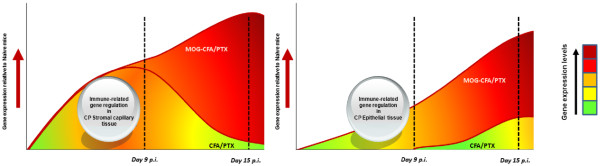
Schematic summary of the induction of immune-related genes in the choroid plexus compartments following MOG-CFA/PTX versus CFA-PTX immunization. Depicted are qualitative ‘heat maps’ of overall modulation in immune-related gene expression patterns over time, within the separate CP stromal capillary (left) and CP choroidal epithelial (right) tissues after the two type immunization regimens. While CFA/PTX immunization alone induces expression of immune-related genes in both tissues, MOG-CFA/PTX immunization causes supernumerary stimulation above this level. The differences in gene expression between the immunization regimens highlight what might reflect gene changes specifically due to MOG-associated autoimmunity. The effects due solely to CFA/PTX immunization might reveal priming of the immune response that is necessary for the development of EAE.